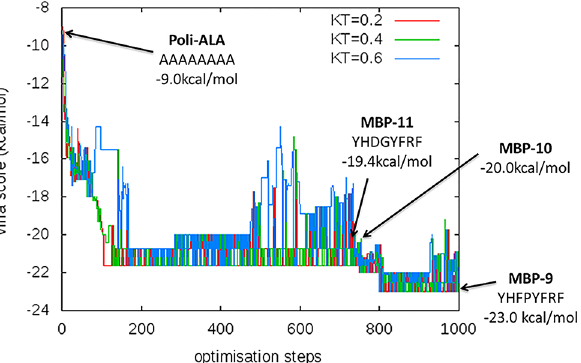
Fig 2. Computational generation of peptides. Autodock Vina binding energy evolution as a function of the optimization steps for the generation of MBP-9. Arrows indicate the energy associated with the starting poly- alanine, MBP-9, and two peptides along the minimization path: MBP-10 and MBP-11.